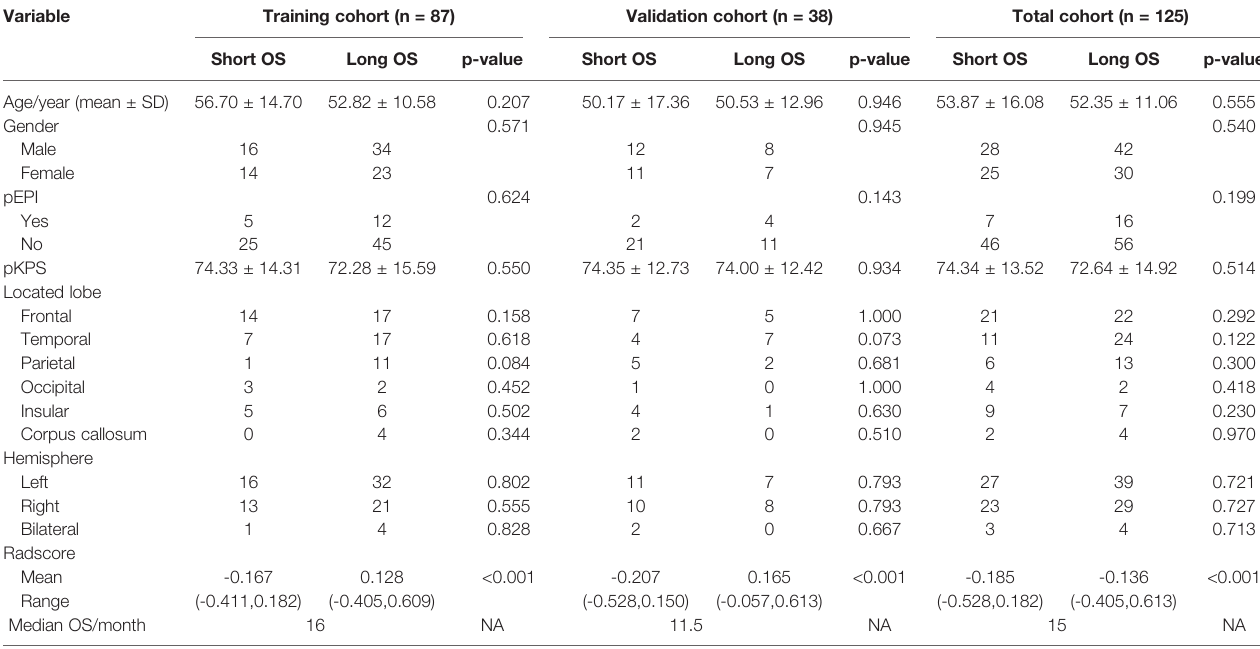
TABLE 1 | Characteristics of GBM patients in the training cohort and validation cohort.